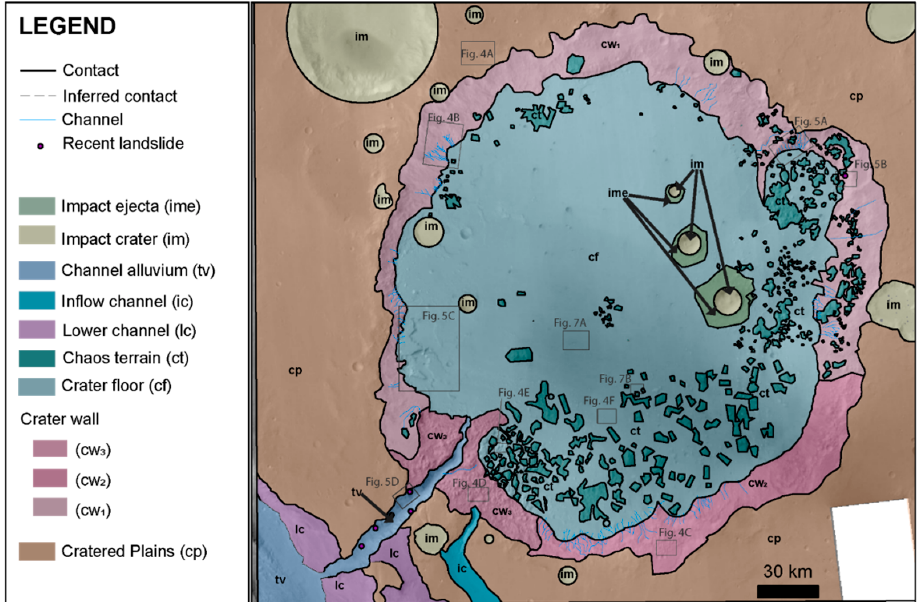
Figure 3. Geomorphic map of Galilaei crater and its surroundings. Units and unit boundaries are shown partially transparent over CTX mosaic basemap. Note that the chaos terrain is preferentially near the crater wall and dominantly in the south and southeast of the crater interior, east of the Tana Vallis outflow channel (tv). Locations of subsequent figure panels are boxed and labeled.